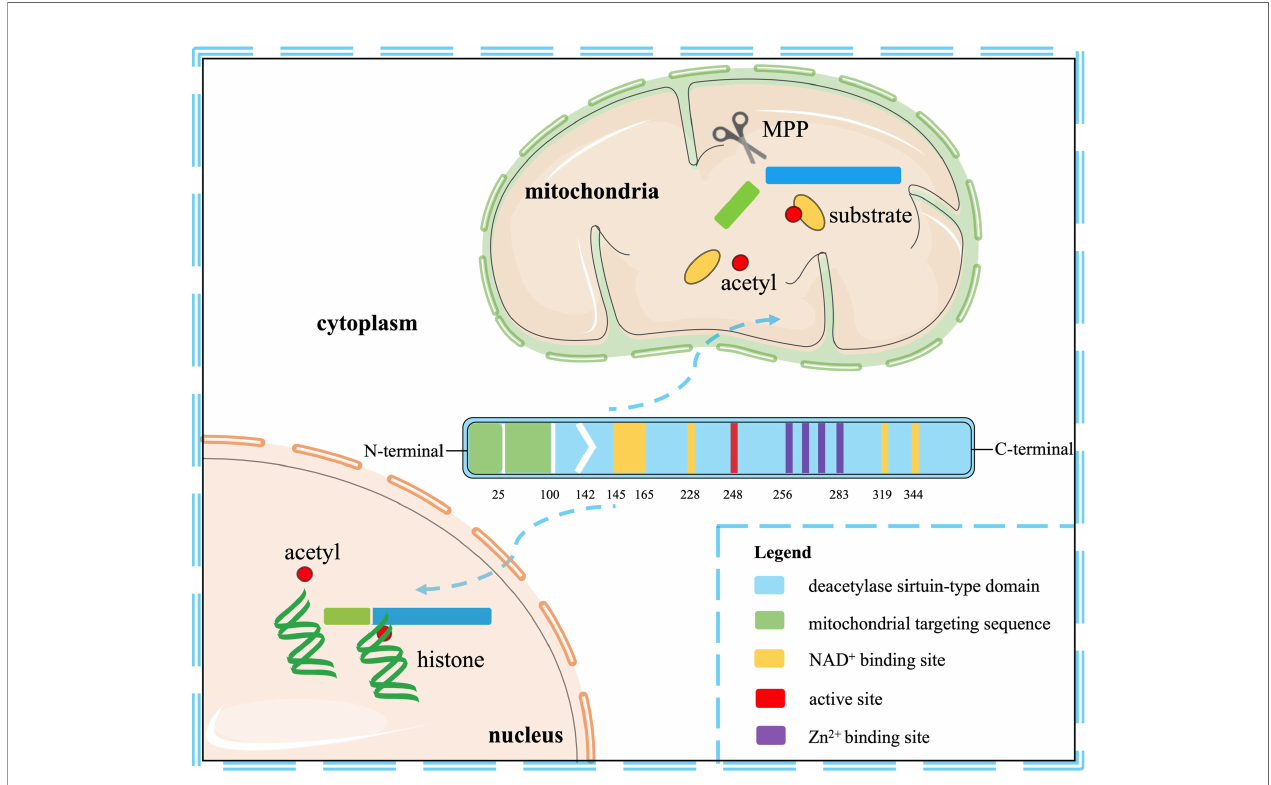
FIGURE 1 | The location and structural composition of SIRT3. The conserved enzymatic core of SIRT3 contains an active site, four Zn 2+ sites, four NAD + sites, and a mitochondrial targeting sequence. SIRT3 is directed to the mitochondria through the targeting sequence, where it is cleaved by the mitochondrial MPP to produce mature proteins. As a deacetylase, it is primarily localized to mitochondria, but also shows histone deacetylation activity in the